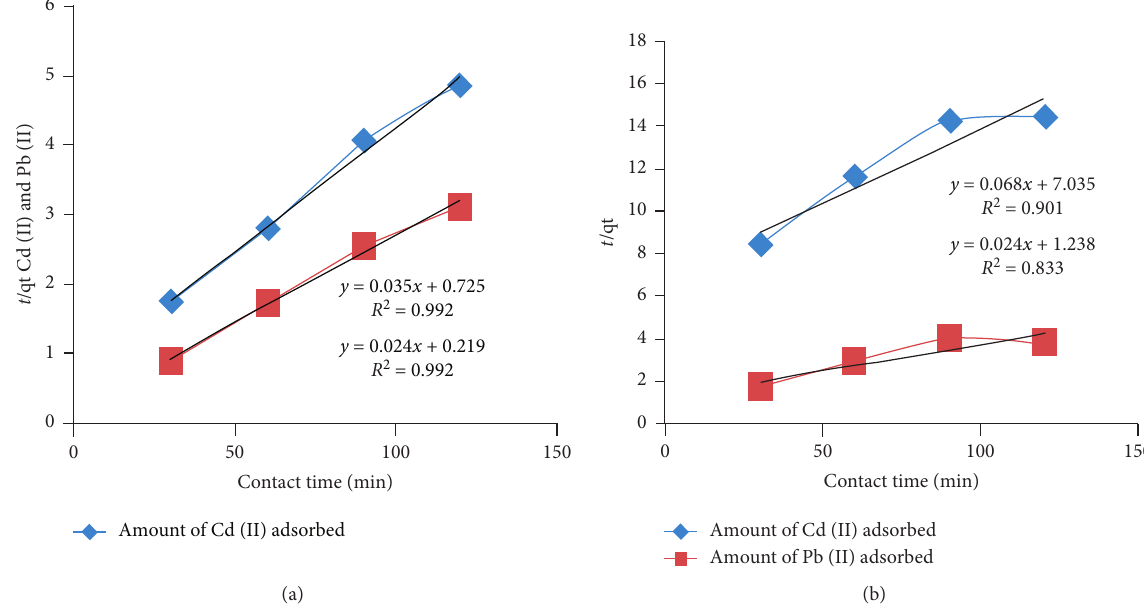
Figure 3: Graph of time dependent of Cd 2+ (blue) and Pb 2+ (red) on clay-1 (a) and clay-2 (b) (2 nd order).